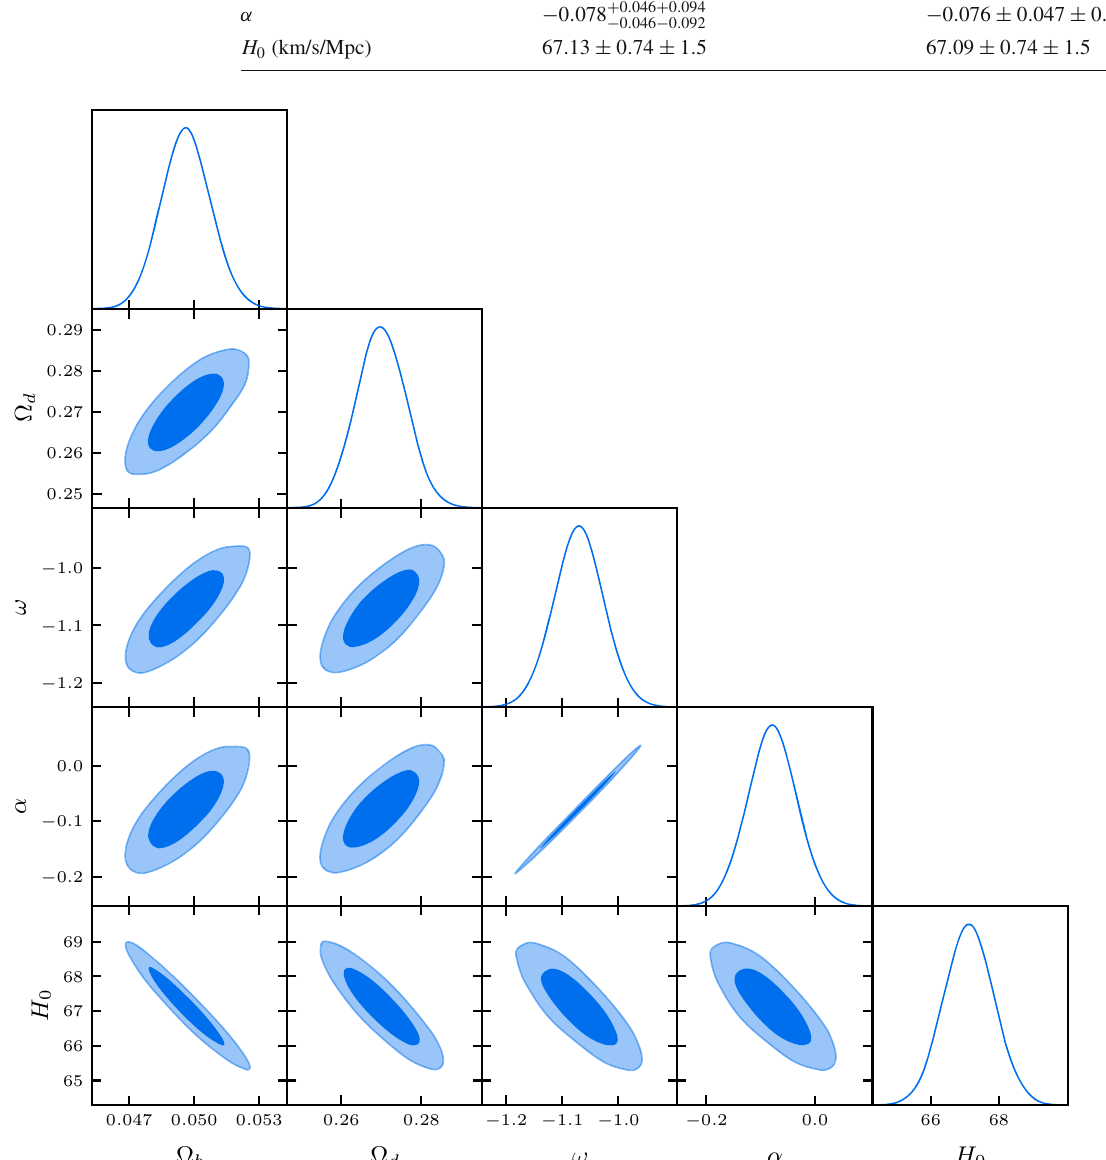
0 . 0064 for XCDM prior, which are very close to the value obtained from Planck (2018) [30], (cid:11) m 0 = 0 . 3153 ± 0 . 0073. The values for H 0 are also compatible with Planck (2018) [30], H 0 = 67 . 36 ± 0 . 54 km/s/Mpc, for both priors. The results obtained for the DE EOS parameter, as can be seen in Table 3, is compatible with − 1 at 1.6 σ for (cid:4) CDM